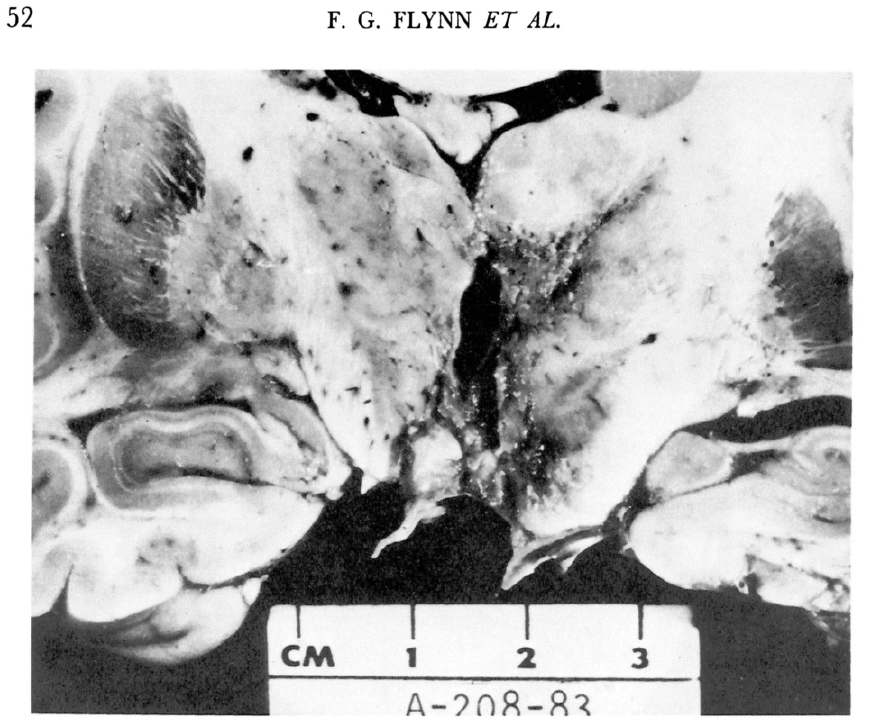
FIG. 2. Coronal section of the brain demonstrates extensive right hypothalamic and left ventromedial hypothalamic damage. There is involvement of the right thalamus and internal capsule. Surgical damage to the right temporal lobe is also